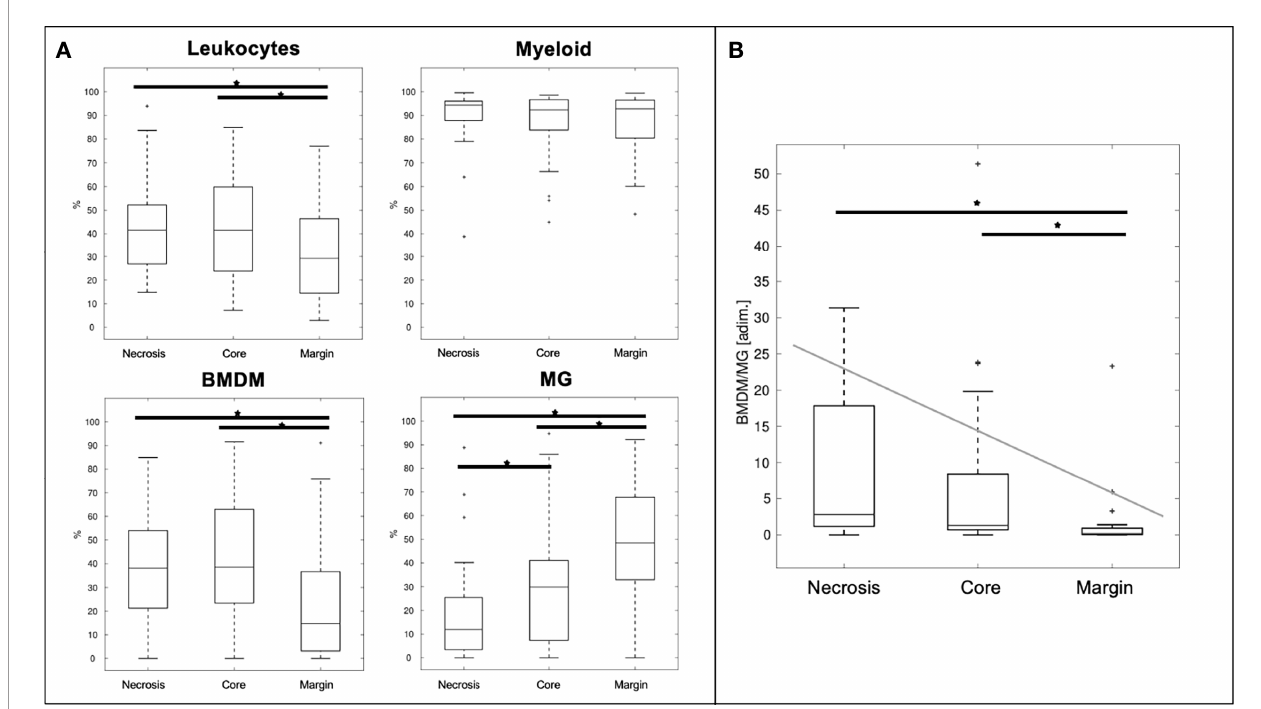
FIGURE 4 | Distributions of the investigated immune populations (A) and ratio between BMDM and MG (B) at different sampling sites. * = signi fi cant differences (p < 0.05), leukocyte in fi ltrate = CD45 + cells gated inside live cells; myeloid = CD33 + cells gated among CD45 + cell; BMDM = bone marrow-derived macrophages HLA-DR + /CD49d + cells gated inside myeloid cells; MG = microglia HLA-DR + /CD49d - cells gated inside myeloid cells